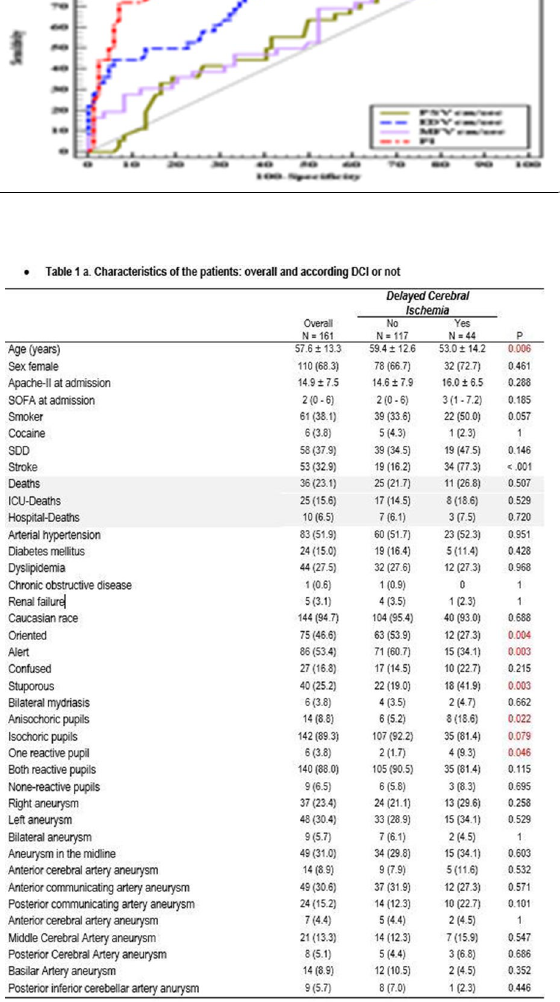
ROC curves for TCD measurements to predict SND. Conclusion. TCD, when done early after admission, is useful in iden- tifying patients at risk for developing neurological deterioration after mild and moderate TBI. EDV and PI are good predictors of SND at one week as well as GOSE at one month. PI is a good predictor for in-hos- pital